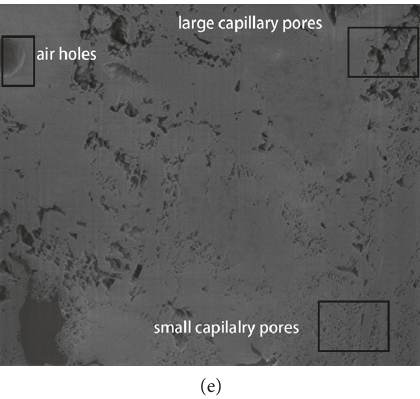
Figure 3: Raw images and segmented porous volume of hardened cement paste by FIB/SEM: (a) original images of FS1; (b) segmented porous volume of FS1; (c) original images of FS2; (d) segmented porous volume of FS2; (e) 2D image by